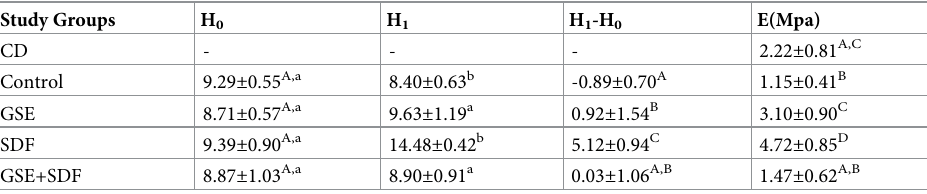
Table 1. Means ± SD of Knoop hardness and modulus of